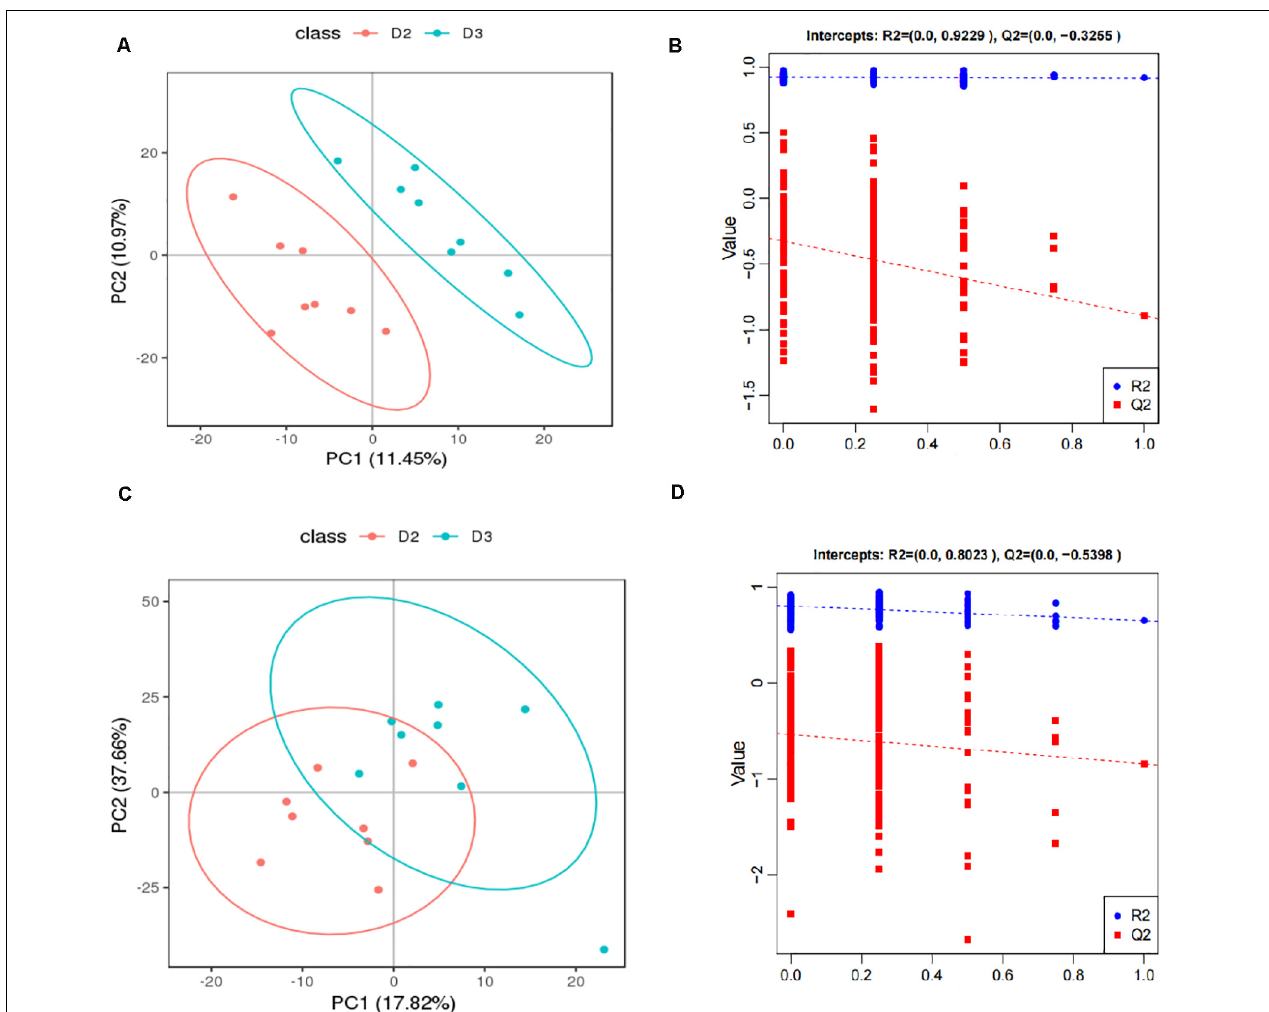
FIGURE 2 | The score plots and validation plots of PLS-DA from liver metabolite profiles of American eel in the HIS group and OPC group under positive ion mode (A,B) and negative ion mode (C,D) ( n = 8). D 2 = HIS group, D 3 = OPC